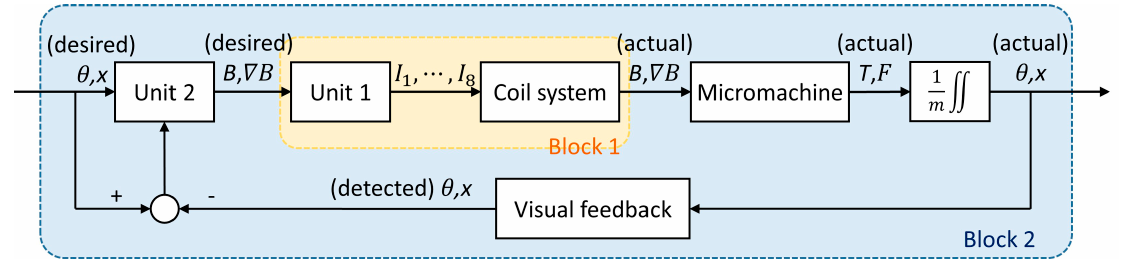
Figure 4. Position and direction control of the micromachine by magnetic actuation.